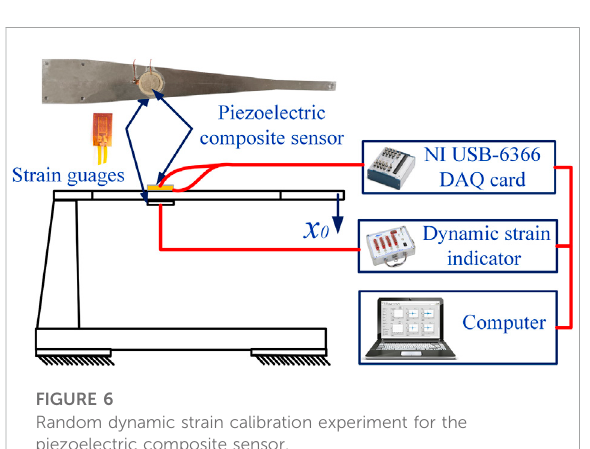
FIGURE 6 Random dynamic strain calibration experiment for the piezoelectric composite